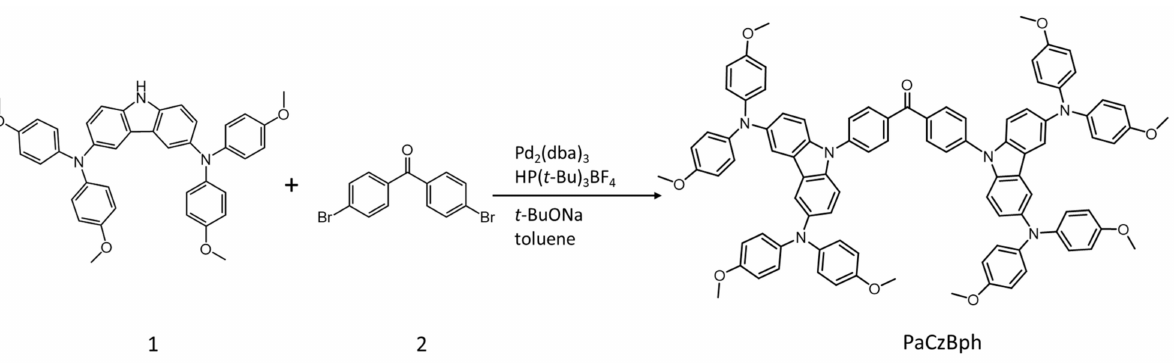
Figure 15. Syntheses of QAh and NAh. Republished from [77] with permission from the Royal Society of Chemistry.